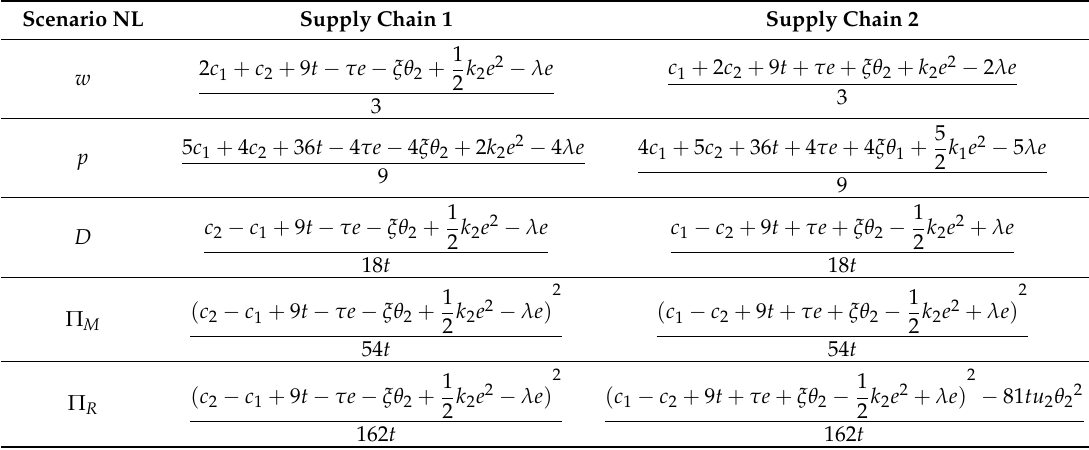
Table 3. Equilibrium outcomes with subsidy under scenario NL.